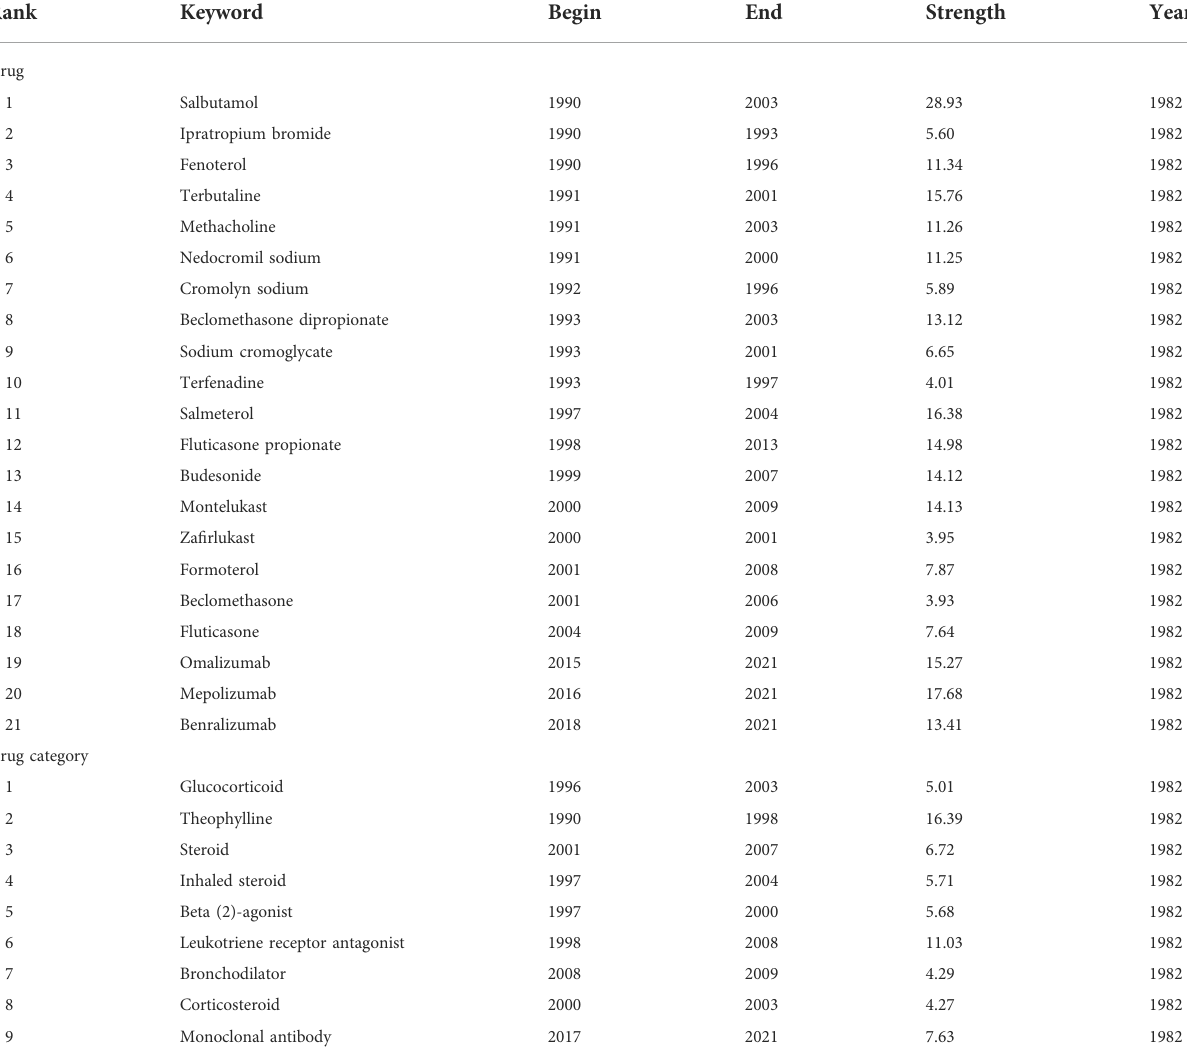
TABLE 3 Keywords of asthma drugs with strongest citation bursts in asthma drug-related